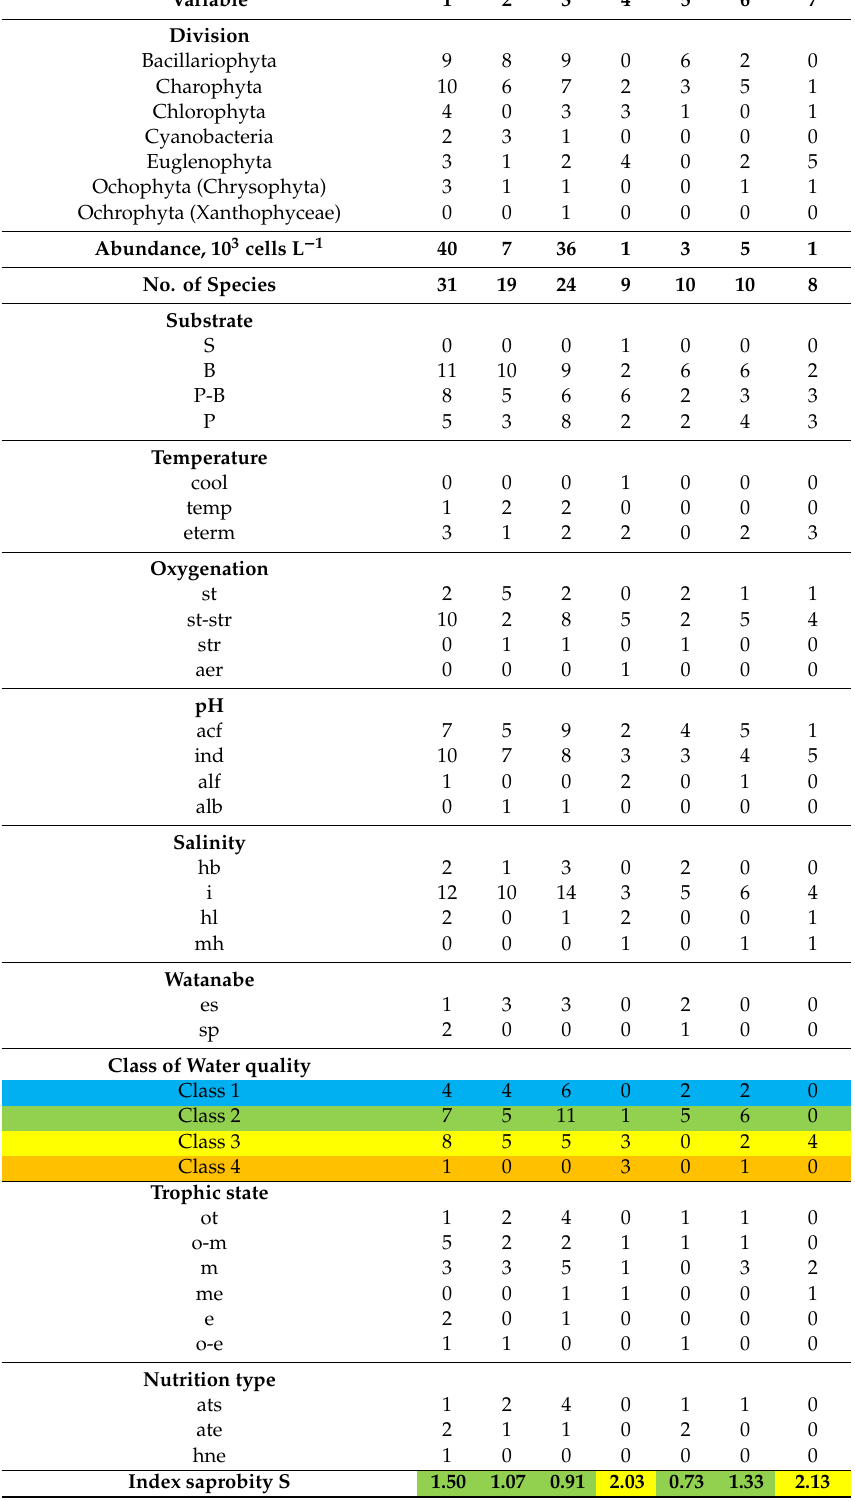
Table 3. Calculation results of taxonomic and bioindication analysis of algae and cyanobacteria composition in the studied sites of the bogs of the Ershov oil field in the Vakh River of the